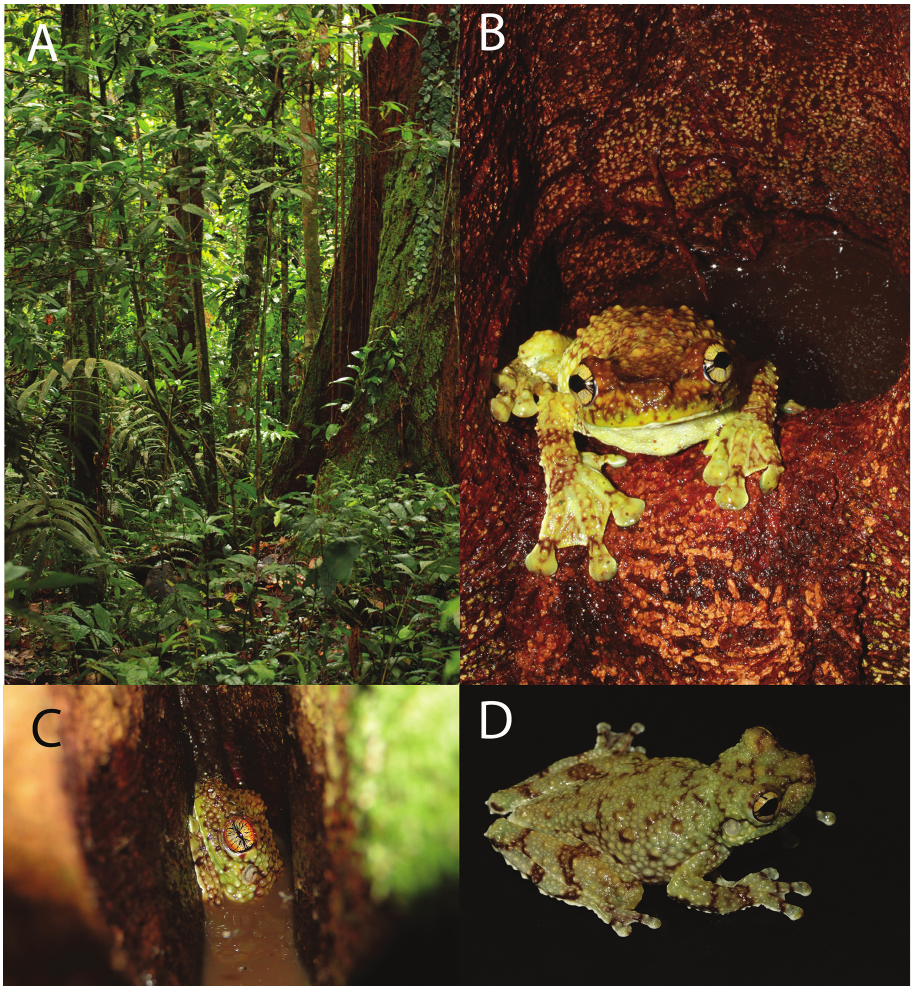
Figure 10. Life individuals and habitat of Tepuihyla shushupe sp. n. and Tepuihyla tuberculosa comb. n. A habitat of Tepuihyla tuberculosa comb. n. at Juyuintza, Provincia Pastaza, Ecuador B Adult male of Tepuihyla tuberculosa comb. n. (QCAZ 53542) sitting at the entrance of the tree hole where he was calling C Adult male of Tepuihyla shushupe sp. n. (CORBIDI 12513, holotype) partly submerged in the water ac- cumulated on the tree hole where he was calling D Tepuihyla tuberculosa comb. n. (CRBIIAP 1839) from the vicinity of Puerto Almendras, Loreto, Peru. Photographs: A, B by M. Ortega, C by A. Del Campo, D by G.